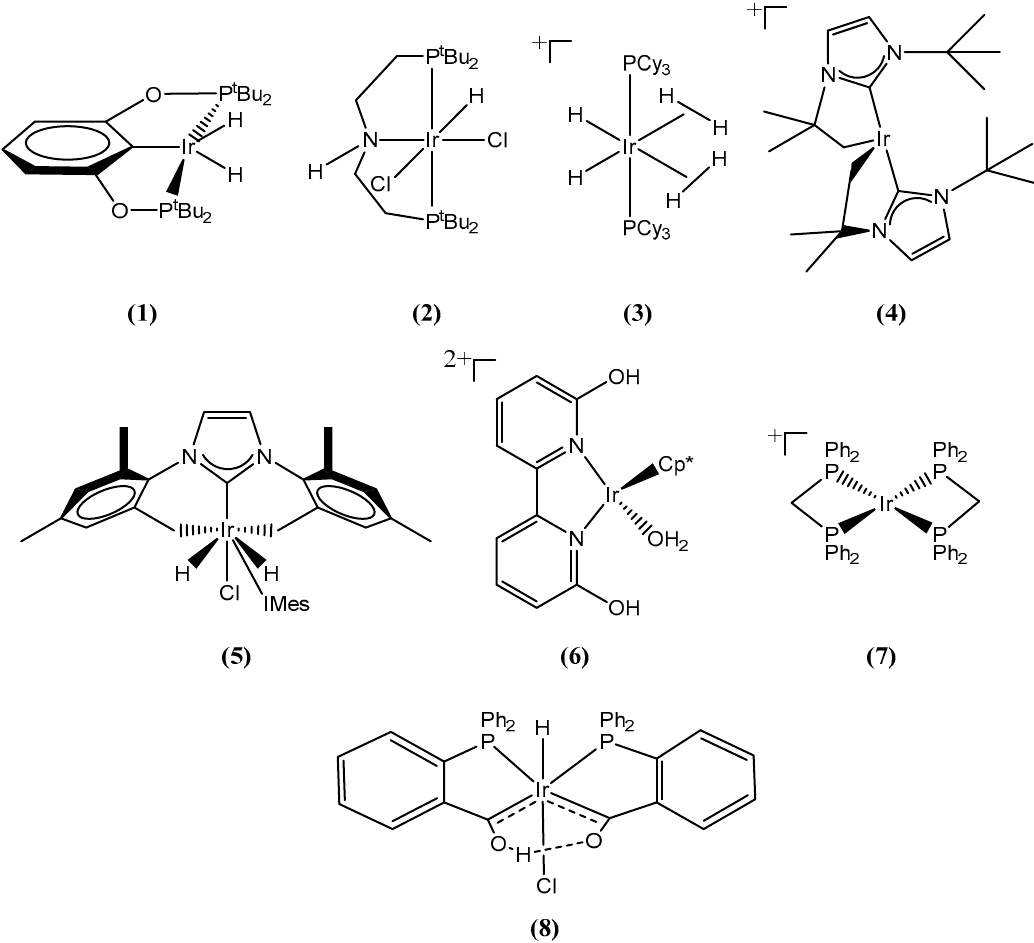
Figure 1. Various homogeneous iridium catalysts that are capable of releasing H 2 from ammonia borane: (1) η 3 -1,3-(OP t Bu 2 ) 2 C 6 H 3 , (2) NH[(CH 2 ) 2 P( t Bu) 2 ] 2 IrCl 2 H, (3) [IrH 2 ( η 2 -H 2 ) 2 (PCy 3 ) 2 ] + , (4) [IrH 2 (I t Bu) 2 ] + [I t Bu = 1,3-bis(tert-butyl)imidazol-2-ylidene], (5) Ir(IMes) 2 H 2 Cl, (6) [Cp*Ir(6,6’-(OH) 2 -bpy)(OH 2 )] 2+ , (7) [Ir(dppm) 2 ] + , (8) IrHCl[(PPh 2 ( o -C 6 H 4 CO)) 2 H].